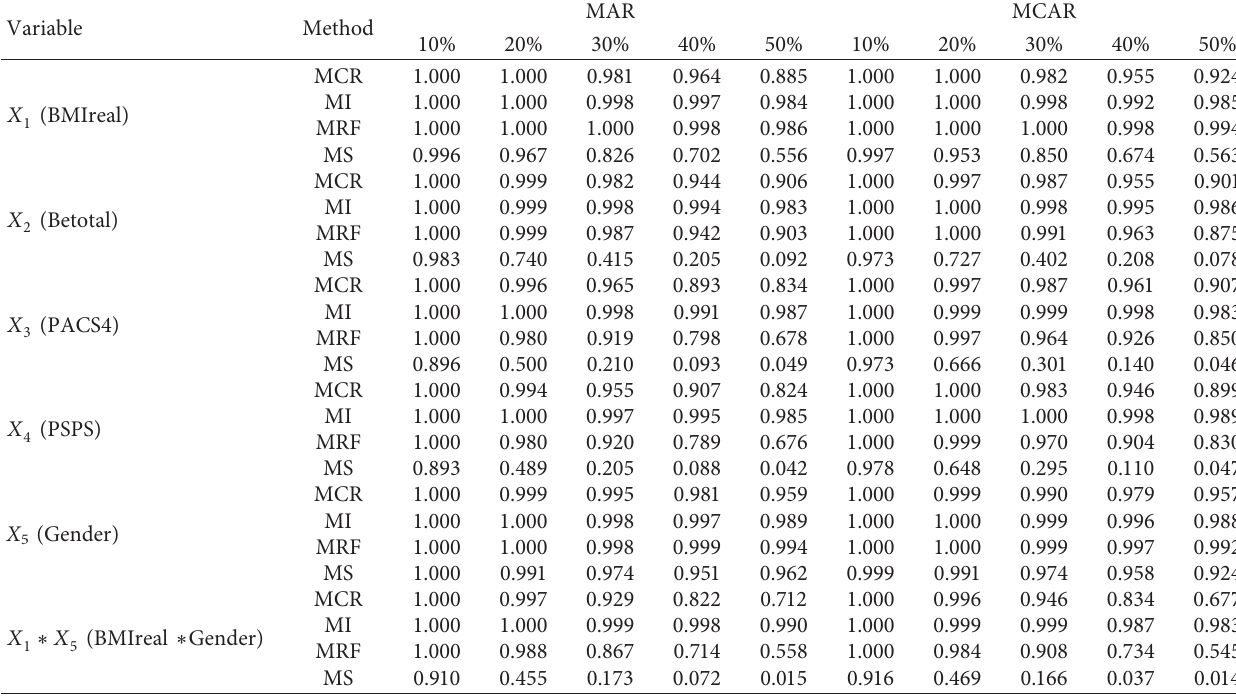
Table 3: Comparison of the performance of imputation methods based on the CRs of regression coefficients over 1000 simulations. Variable Method